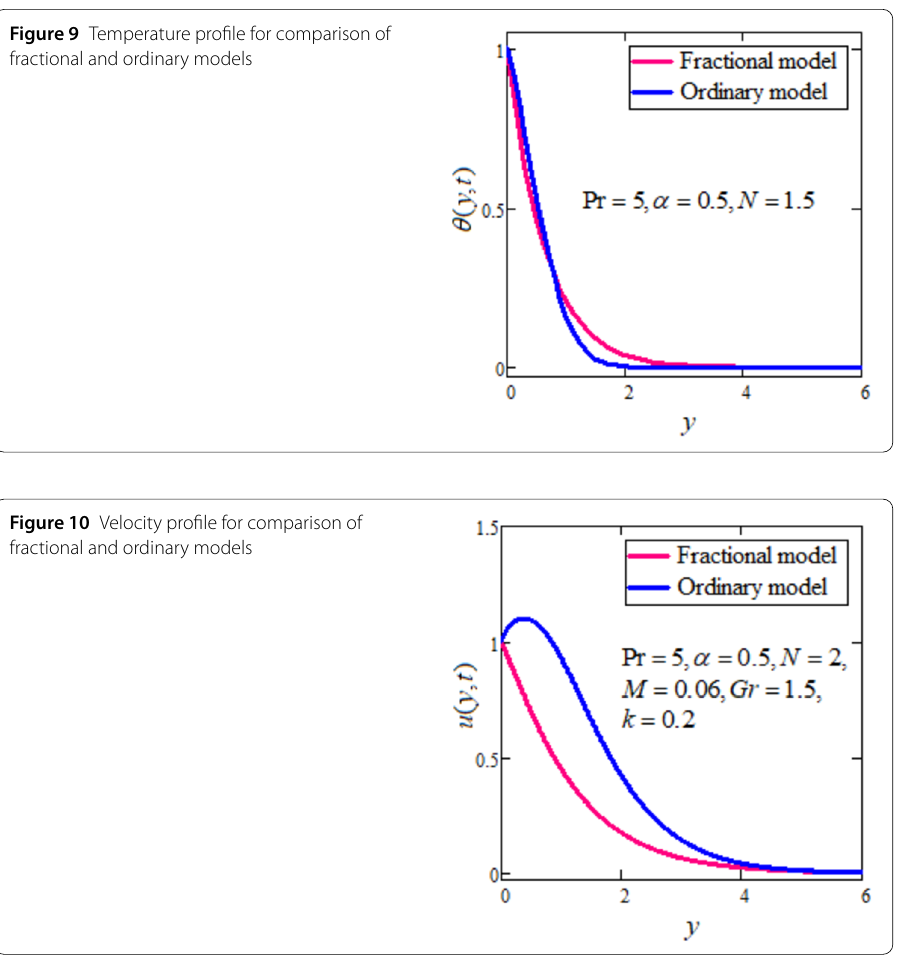
Figure 9 Temperature profile for comparison of fractional and ordinary models